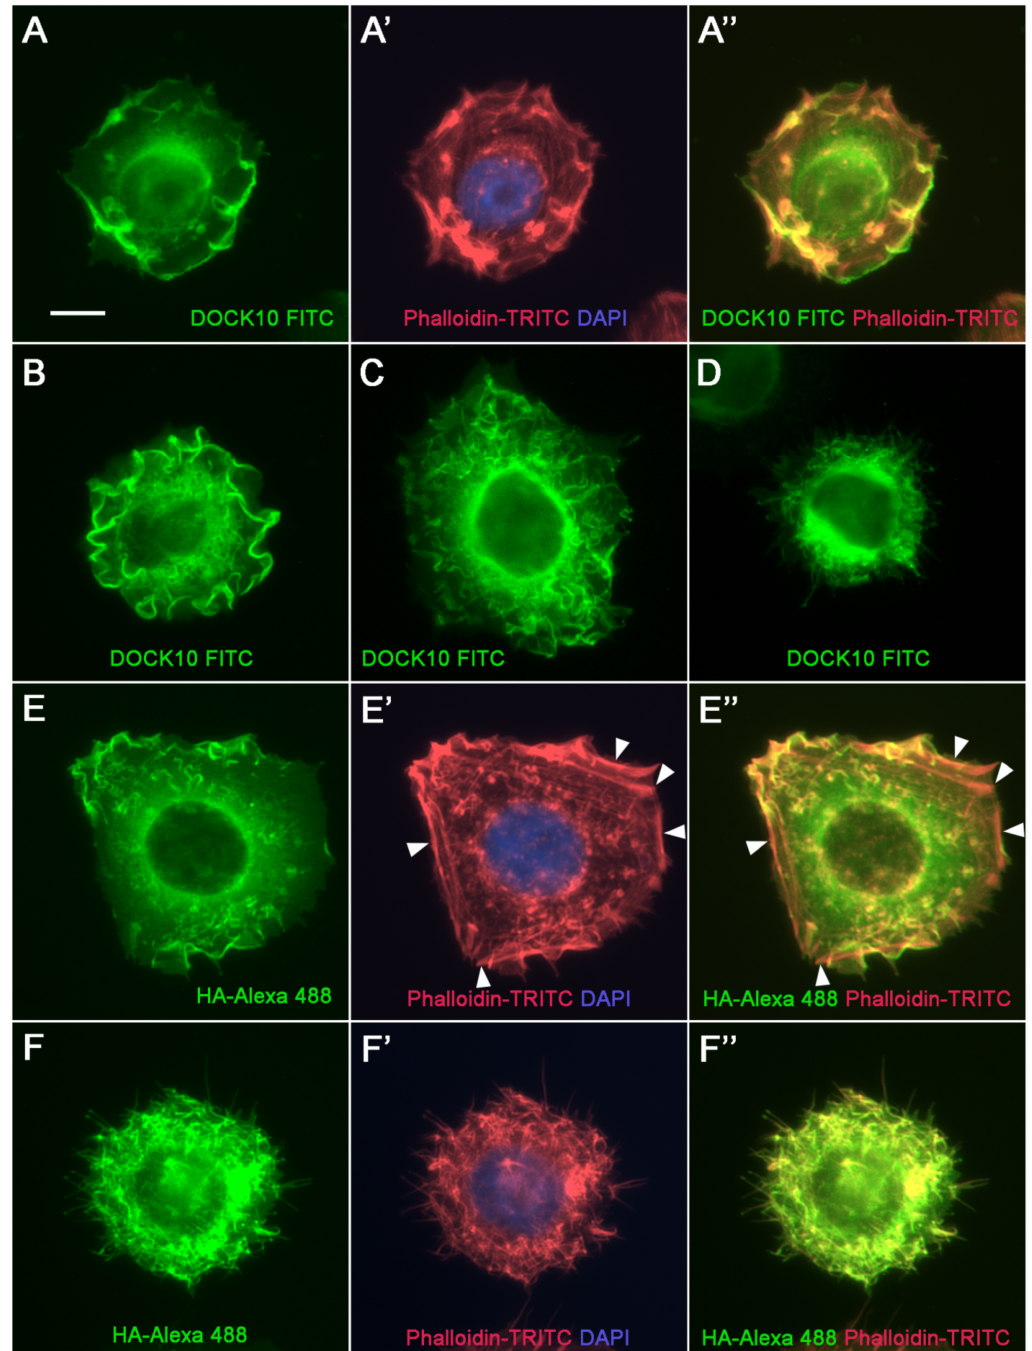
Figure 4. Localization of DOCK10 in PM ruffles and filopodia in transfected HeLa cells using a DOCK10 antiserum. IF microscopy analysis of a HeLa clone with inducible expression of HA-DOCK10, washed free of dox, reseeded without dox on poly-L-lysine coating, and cultured for 24 h. Cells were labelled with rabbit anti-DOCK10 antiserum (micrograph series A and micrographs B – D ) or rat anti-HA Ab (micrograph series E , F ), followed by FITC-conjugated swine anti-rabbit Igs (green) or Alexa Fluor 488-conjugated goat anti-rat Igs (green), respectively, phalloidin-TRITC (red), and DAPI (blue). ( A – F ) Labelling with FITC- or Alexa Fluor 488-conjugated Igs ( A’ , E’ , F’ ). Merge of phalloidin-TRITC and DAPI labelling. ( A” , E” , F” ). Merge of labelling with FITC- or Alexa Fluor 488-conjugated Igs and phalloidin-TRITC. Micrograph series ( A , E ), and micrographs ( B , C ), illustrate the extensive presence of DOCK10 in the membrane ruffles. Arrowheads in ( E’ , E” ) indicate peripheral stress fibers. Micrograph ( D ) and micrograph series ( F ) illustrate that in filopodia-rich cells, DOCK10 locates to filopodia. Objective magnification: 60 × . Scale bar: 10 µ